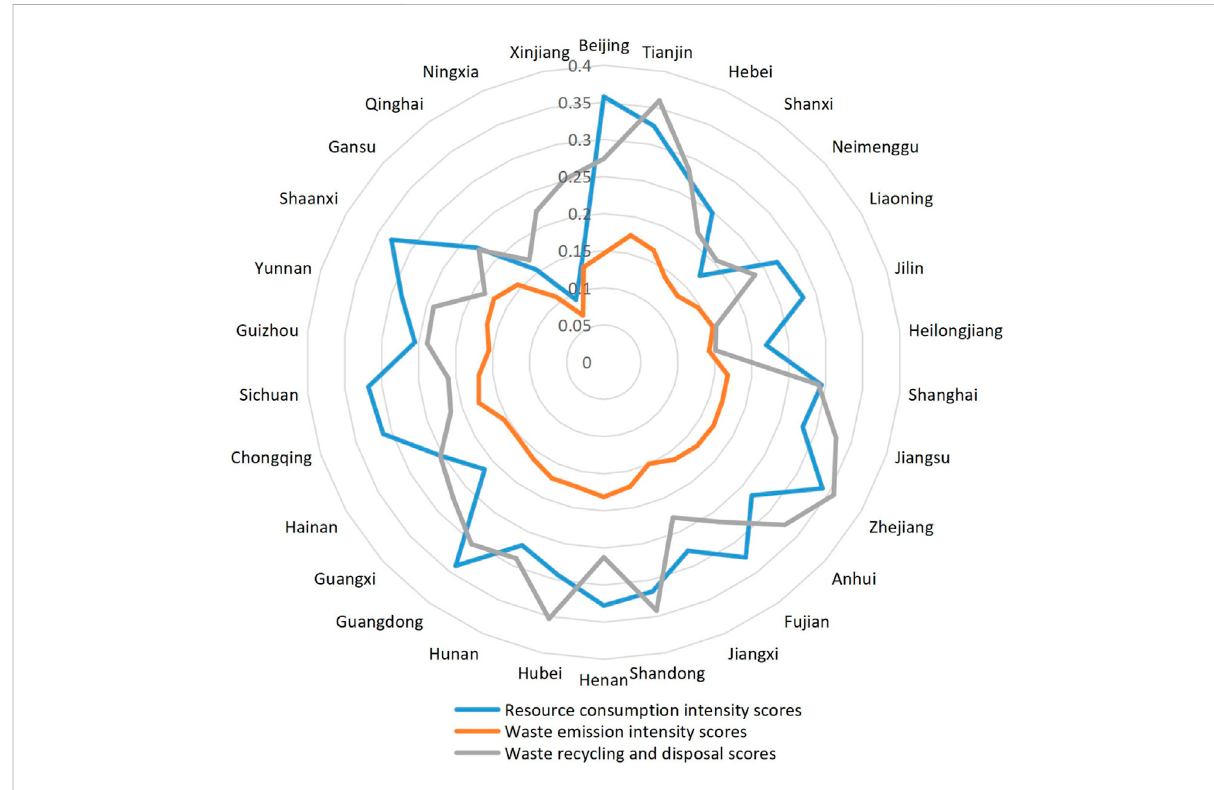
FIGURE 3 Provincial circular economy performance sub-dimension scores.